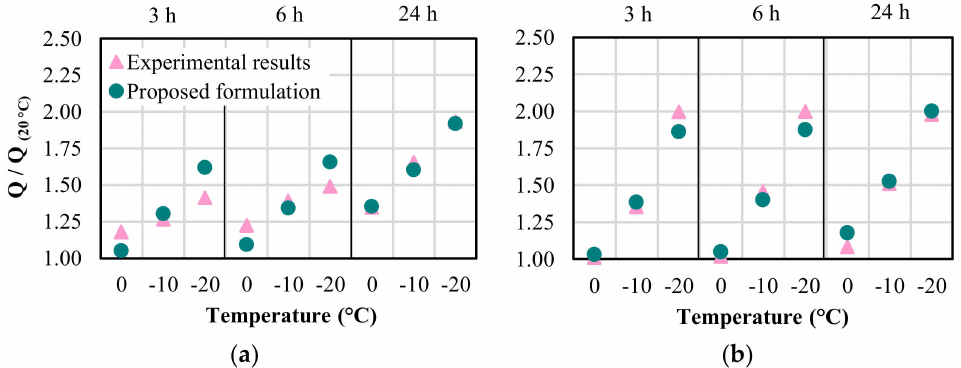
Figure 20. Comparison of experimental amplifications in Q with the proposed formulation estima-